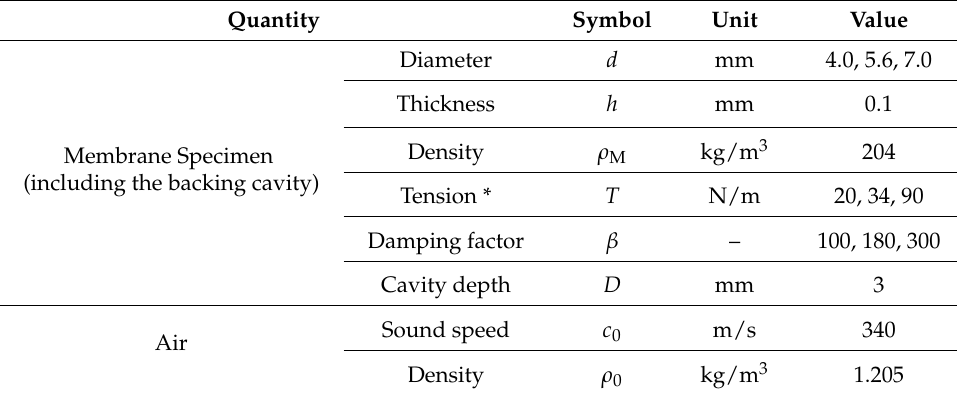
Figure 2. Membrane specimen (including the backing cavity) with a piece of retro-reflective film (half shown here for illustrating the backing cavity) and its composition; detailed specifications provided in Table 1. Table 1. Parameters of the designed membrane specimen with the backing